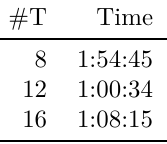
Table 4: Runtime of the parallelized SAT solvers Paracooba [HFB20] and Mallob [SS21] on the 3-round problem with at most 14 differentially active S-boxes, proven unsat by (a) Paracooba with #T CaDiCal instances, 370